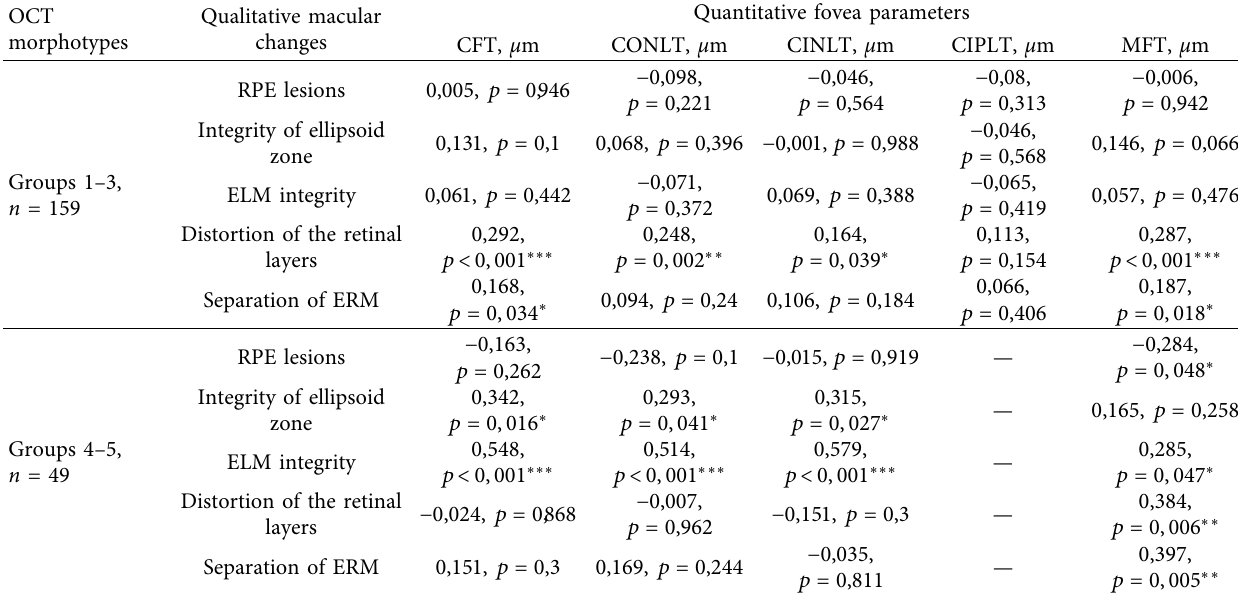
Table 6: Pearson’s correlations ( R 2 ) between quantitative fovea parameters and qualitative macular changes in OCT morphotypes of the ERM with designation of the corresponding significance level ( p -value). ∗ p < 0 , 05, ∗∗ p < 0 , 01, and ∗∗∗ p < 0 ,